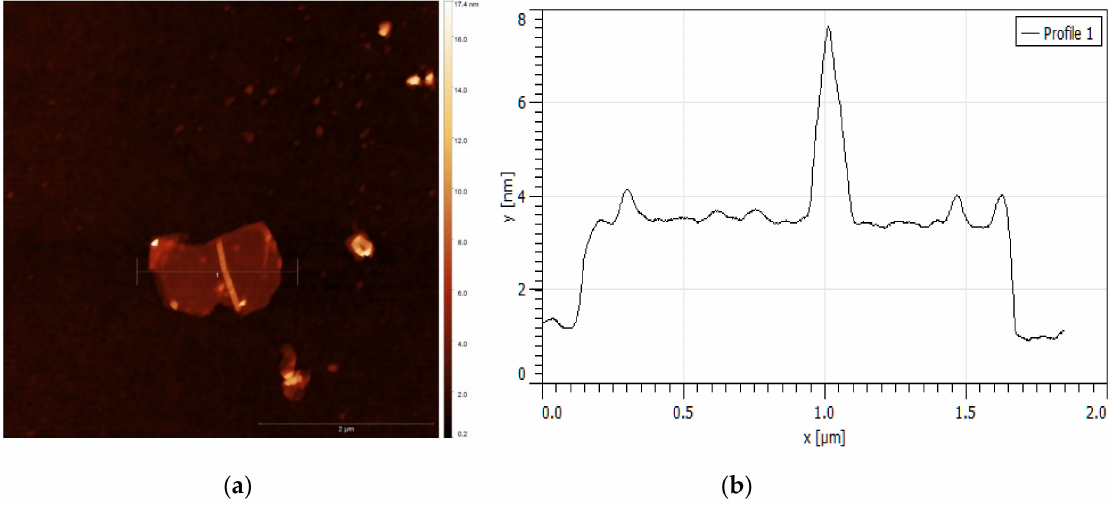
Figure 9. ( a ) AFM images of layered TGO nanosheets on SiO 2 profile with ( b ) corresponding height profile.